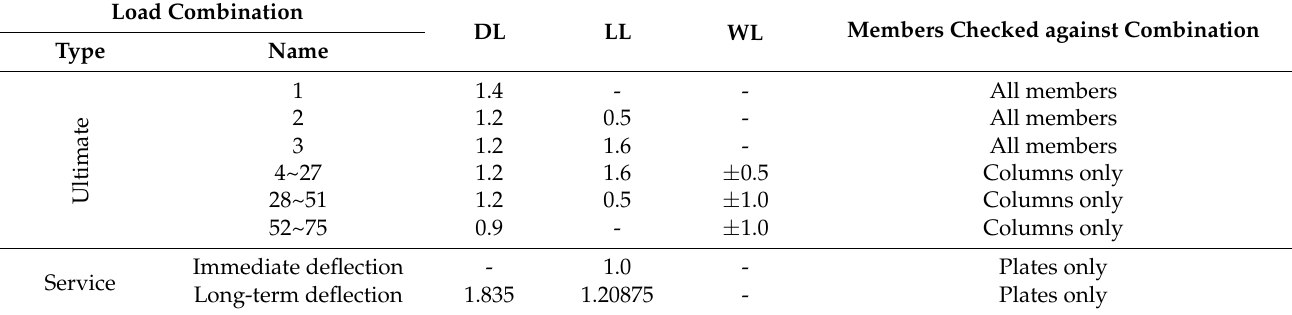
Table 11. Load combinations